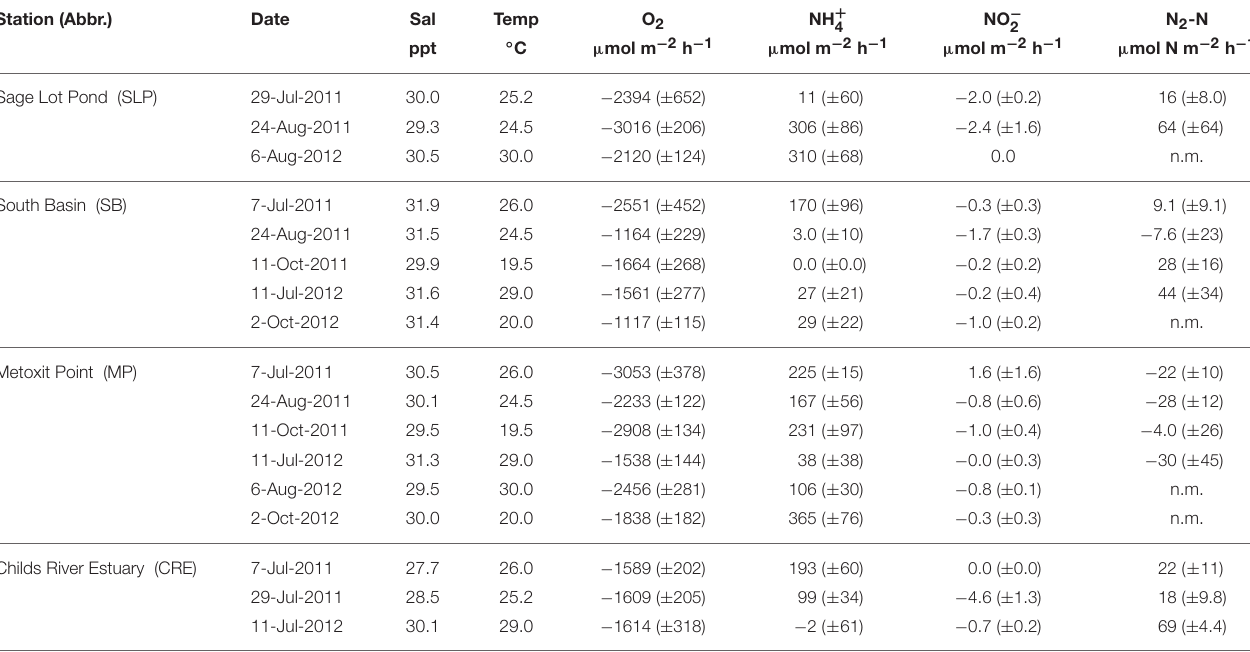
Table 2 | Summary of sediment oxygen (O 2 ), ammonium (NH + 4 ), nitrite (NO − 2 ) and di-nitrogen gas per mole nitrogen (N 2 -N) flux rates measured across the sediment-water interface in Waquoit Bay, MA in 2011 and 2012 (July–October). Station